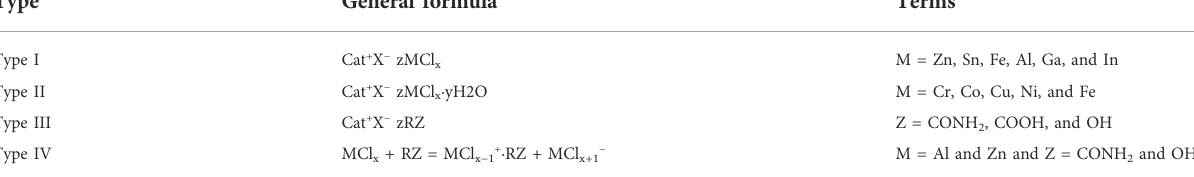
TABLE 1 General formula for the classi fi cation of DESs.